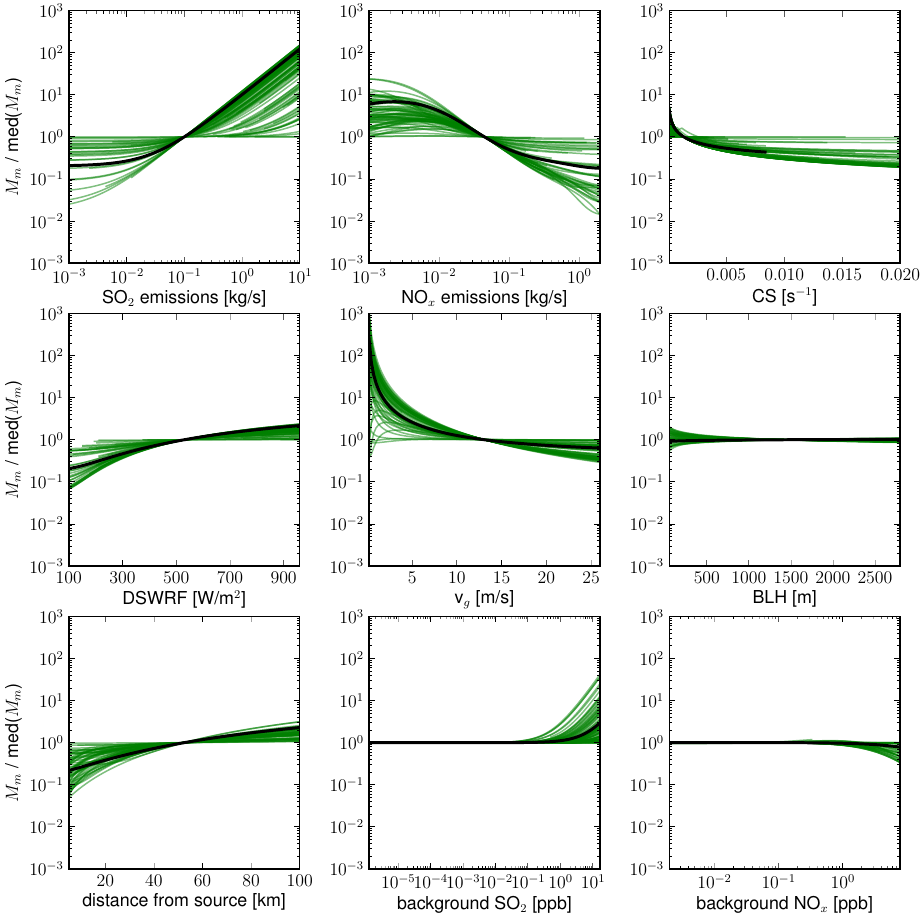
Fig. 3. Sensitivity of M m to each of the inputs for 100 randomly selected sample inputs. If nucleation is not predicted by the P6 parameteri- zation, no value is shown. The black line denotes the median value case. Each plotted line is divided by its median value in order to highlight the sensitivities to the